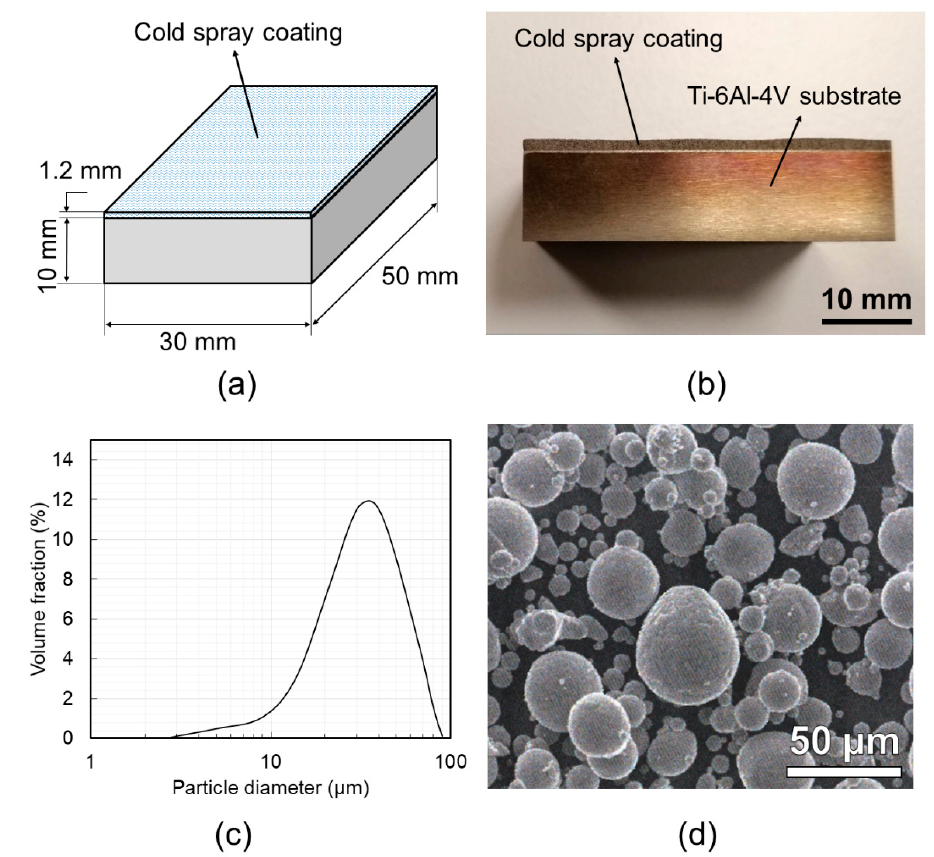
Figure 1. ( a ) Schematic of as ‐ sprayed coupon; ( b ) cold ‐ sprayed coupon; ( c ) cold spray particle size distribution; ( d ) particle morphology. distribution; ( d ) particle